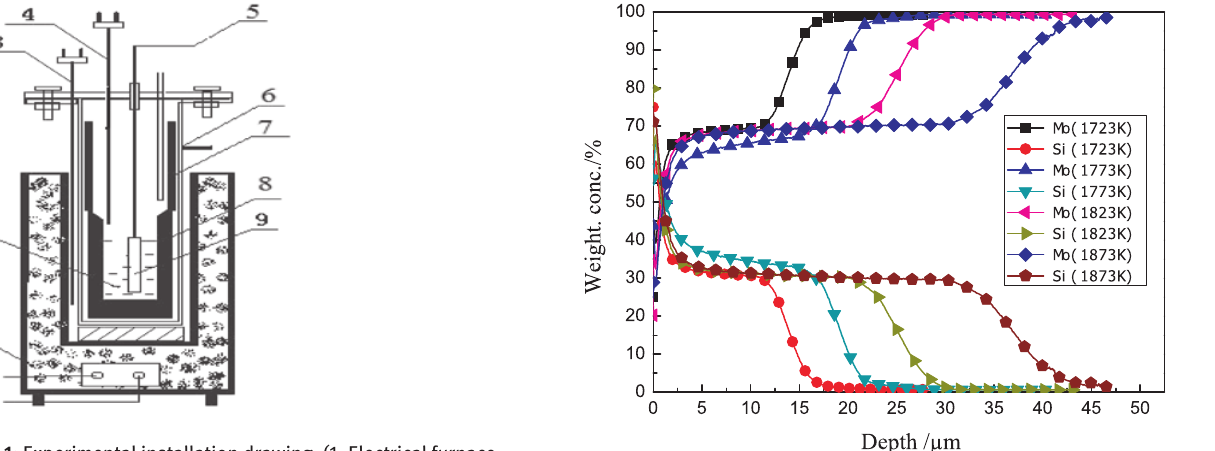
Fig. 1: Experimental installation drawing. (1. Electrical furnace; 2. Molten poly-silicon; 3–4. Thermocouple; 5. Molybdenum wire; 6. Alundum tube; 7. Graphite sleeve; 8. Corundum crucible; 9. Mo sheet)